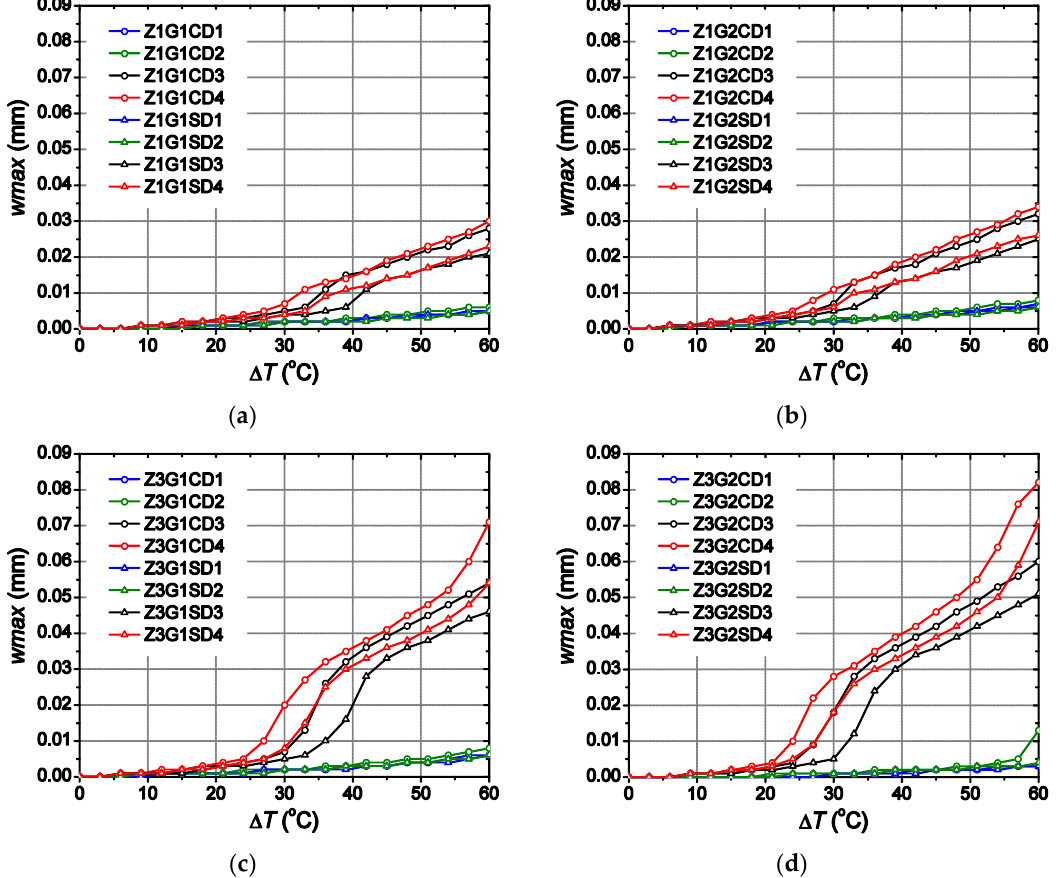
Figure 10. Evolution for the maximum crack opening at di ff erent zones of the sleeper using a specific dowel geometry: ( a ) G1 in Z1; ( b ) G2 in Z1; ( c ) G1 in Z3; ( d ) G2 in